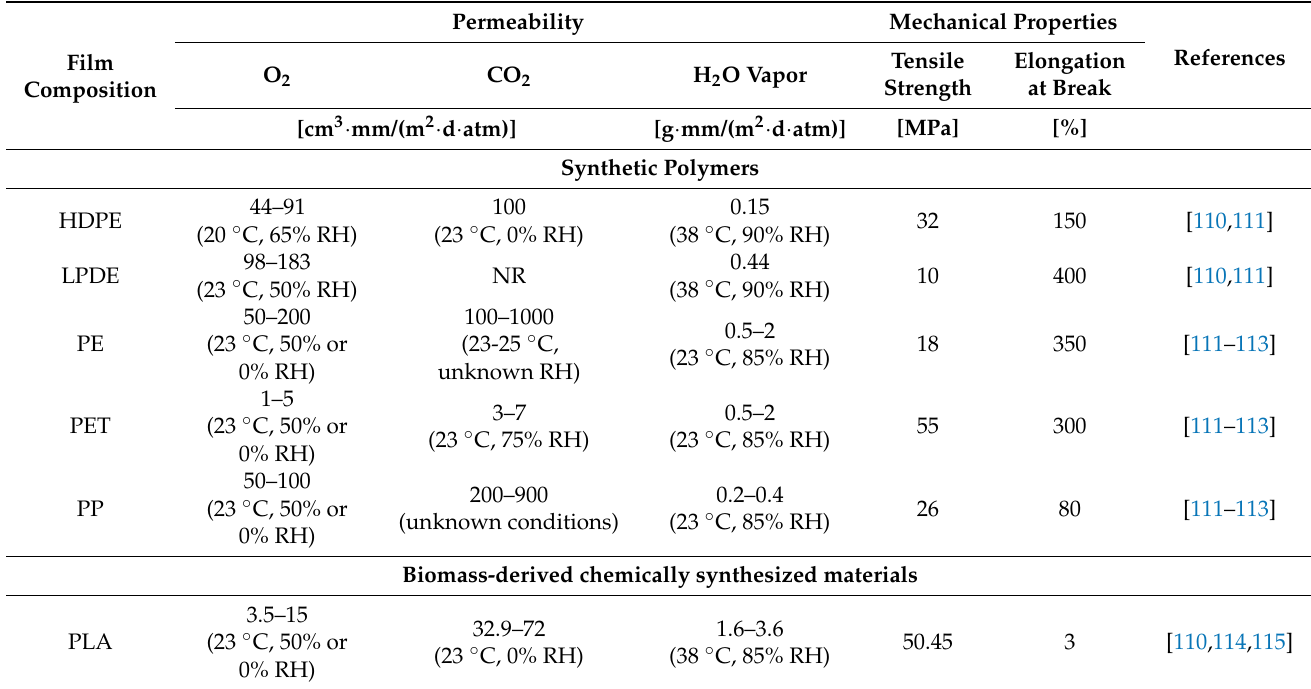
Table 1. Barrier and mechanical properties of selected synthetic polymers and biomass-derived chemically synthesized materials.